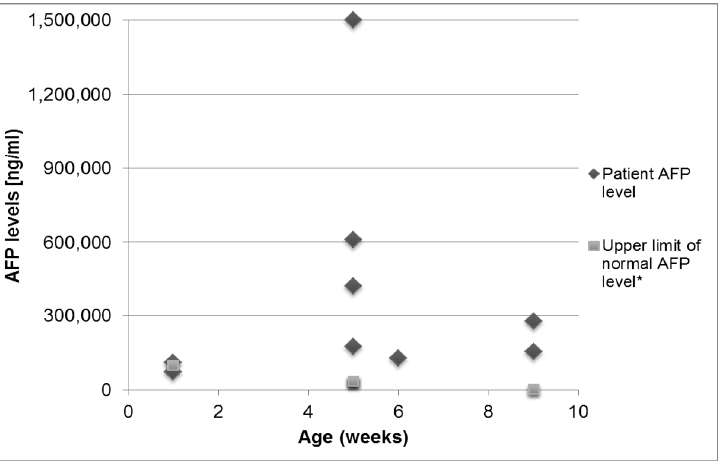
Figure 1. Serum AFP levels in 9 NPC patients which were tested during the first 3 months of life in comparison with age-adjusted norms. * 95th percentile of normal levels according to Lopez-Terrada et al. [18] Table 2. Biochemical Characteristics of 9 patients with NPC.